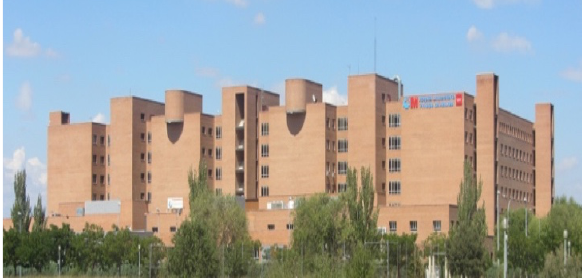
Figure 2. The University Hospital Príncipe de Asturias, Alcalá de Henares,